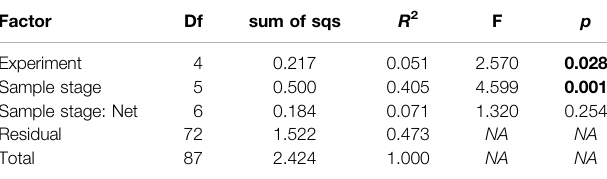
TABLE 5 | Statistics showing the results of factors: “ experiment ” , “ sample stage ” , and “ net ” nested in “ sample stage ” . Factor Df sum of